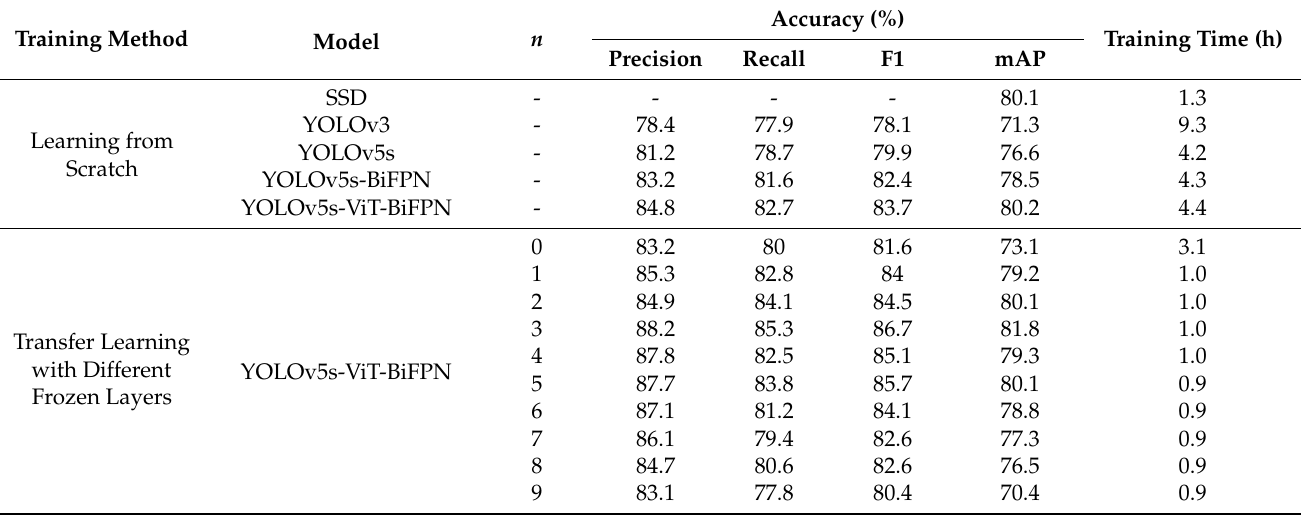
Table 3. Comparisons of accuracy and time for training with different detection models and training methods on the RSDams validation